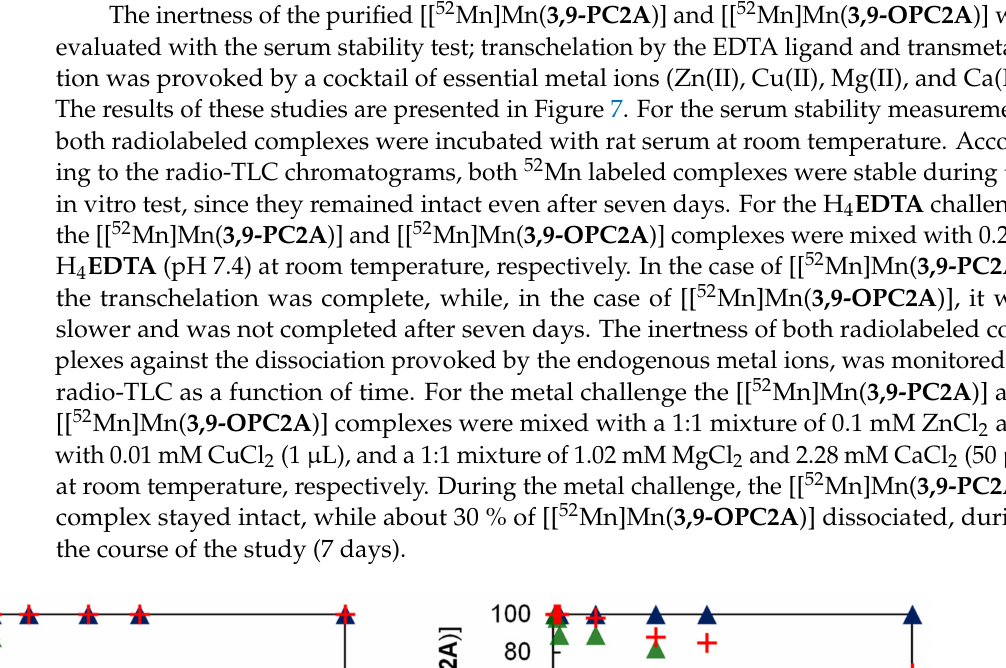
Figure 6. 52 Mn labeling effectiveness of H 2 3,9-PC2A ( a ) and H 2 3,9-OPC2A ( b ) at 37 ◦ C.